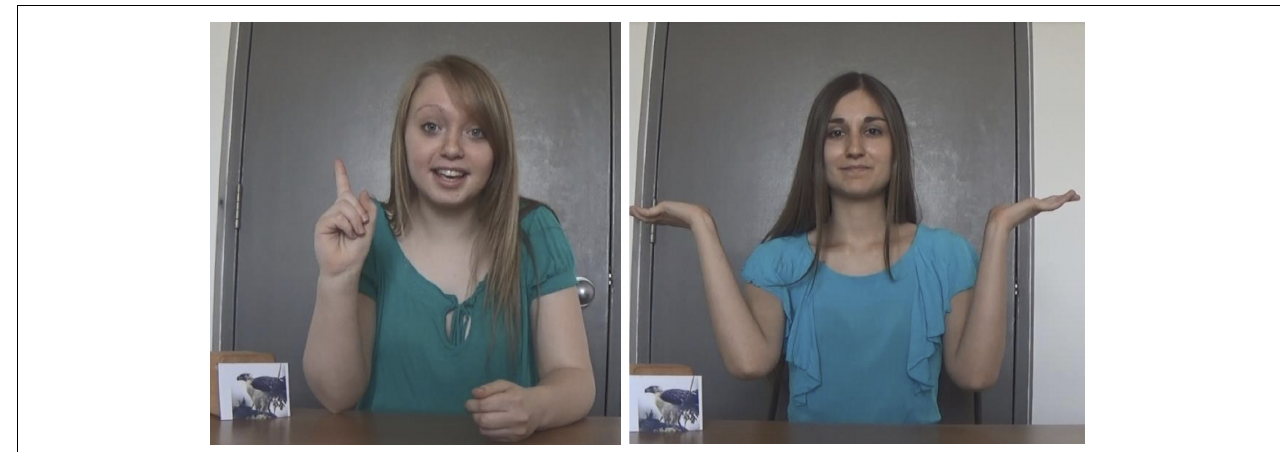
FIGURE 1 | Illustration of a test trial, including confidence and hesitancy cues displayed by “I1” ( left ) and “I2” ( right ) in Form A. Written informed consent was obtained from the individuals in this figure for the publication of their images.